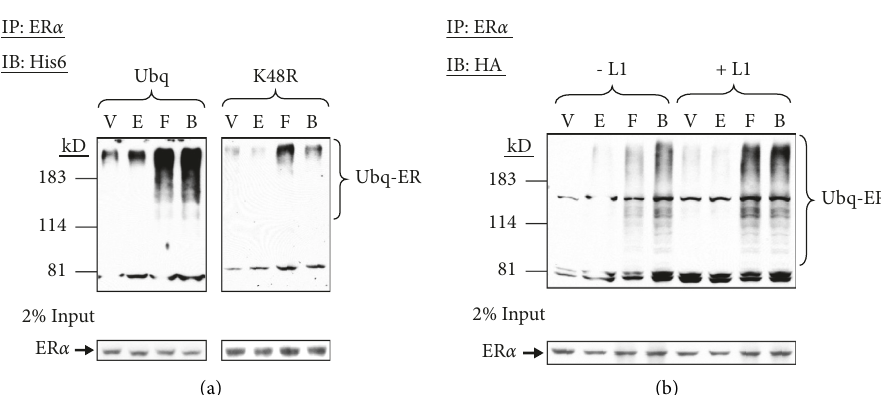
Figure 6: The K48R mutation in ubiquitin reduces estradiol and forskolin-induced ER α ubiquitination. (a) GH3 cells were transfected with His6-tagged, wild-type (Ubq), or K48R mutated (K48R) ubiquitin expression vector (4 μ g). Cells were pretreated with MG132 (40 μ M) for 1h followed by vehicle (V), estradiol (E, 10nM), forskolin (F, 1 μ M), or both (B) for 6h. Cell lysates were subjected to immunoprecipitation (IP) with ER α antibody, and analyzed by immunoblotting (IB) with antibody against His6 to detect ubiquitinated ER α (Ubq-ER) (upper panel). ER α was also detected by immunoblotting (IB) with the ER α antibody from these lysates (lower panel). (b) GH3 cells transfected with HA-tagged ubiquitin expression vector (4 μ g) were pretreated with vehicle (-L1) or the UCH-L1 inhibitor (+L1, 1 μ M) for 1 h followed by vehicle (V), estradiol (E), forskolin (F), or both (B) for 6 h. Ubiquitinated ER α (Ubq-ER) was detected from cell lysates with immuno- precipitated (IP) for ER α and then immunoblotted (IB) for HA (upper panel) while ER α was also detected by immunoblotting (IB) of ER α in parallel (lower panel).